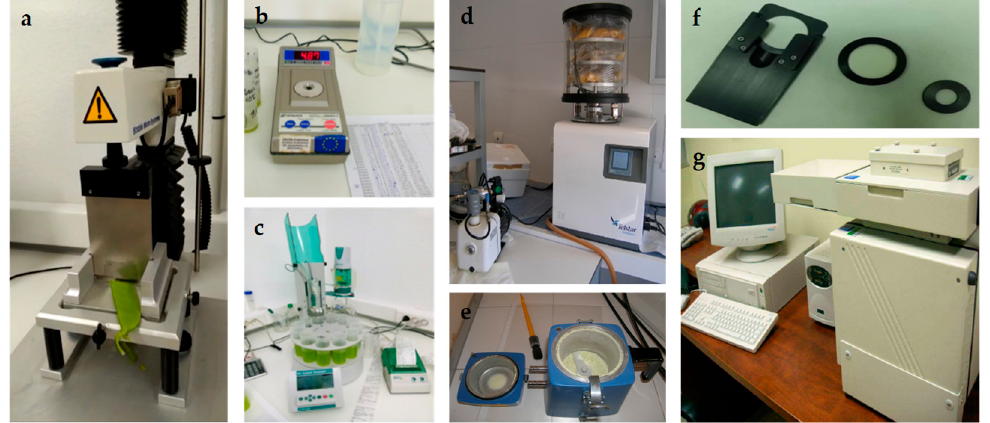
Figure 3. Detail of Texturometer XTPlus Texture Analyzer ( a ); Smart-1 digital refractometer ( b ); Automatic Metrohm 862 Titrosampler ( c ); Freeze-drying equipment ( d ); Mill ( e ); NIRS sample holder ( f ); Spectrometer Model 6500 Foss-NIRSystems ( g ).